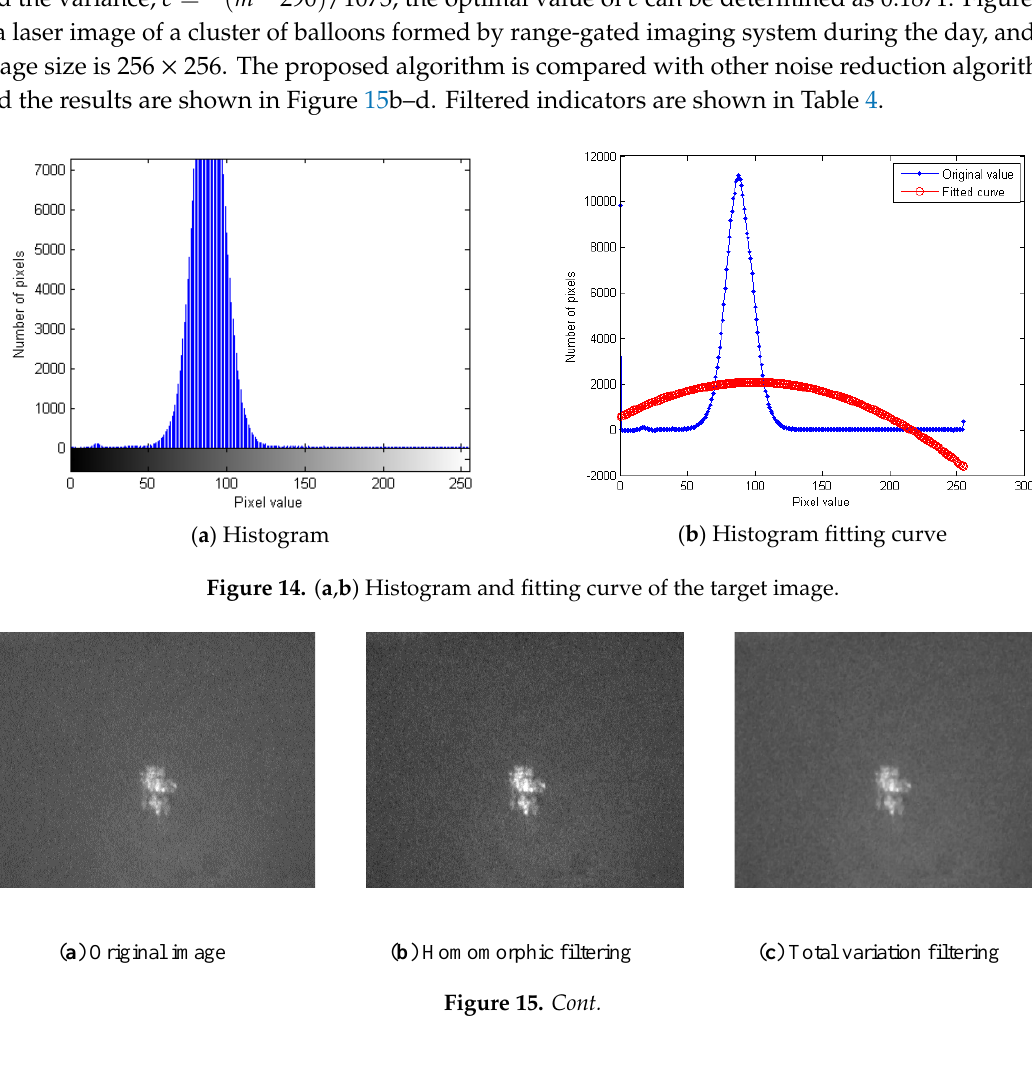
Table 3. Comparison of performance indicators of di ff erent algorithms.